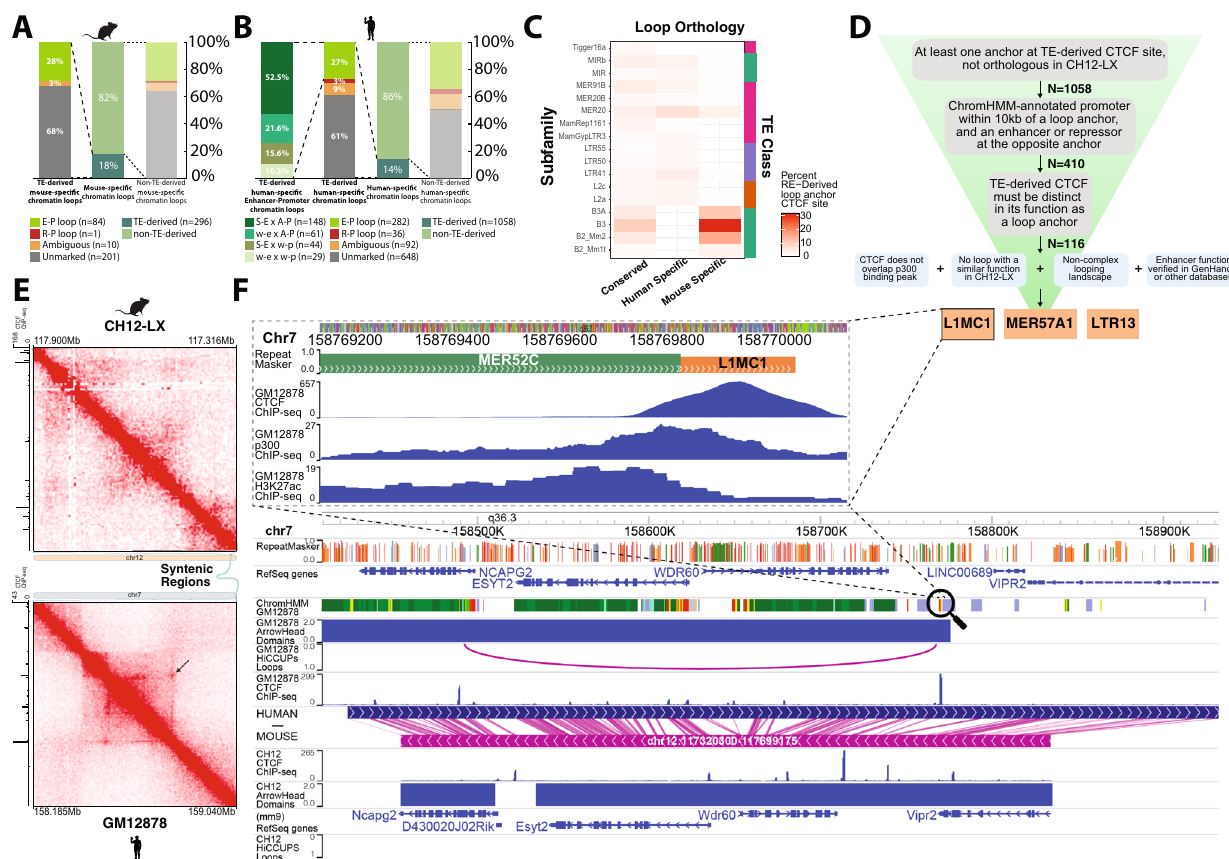
Fig. 3 | TE-derived CTCF binding site expansion as a mechanism for novel 3D genome folding. A Stacked bar plots showing the distribution of different classes of mouse-speci fi c loops based on the origins of the CTCF loop anchor, i.e., TE- derived and non-TE-derived. B Stacked bar plots showing the distribution of dif- ferent classes of human-speci fi c loops based on the origins of the CTCF loop anchor, i.e., TE-derived and non-TE-derived. TE-derived, human-speci fi c enhancer- promoter loopswerefurther functionallyannotated based on the strength of their enhancers and promoters. C TE subfamily contribution to conserved, human-spe- ci fi c, and mouse-speci fi c loops in the lymphoblastoid cell lineage. D Schematic